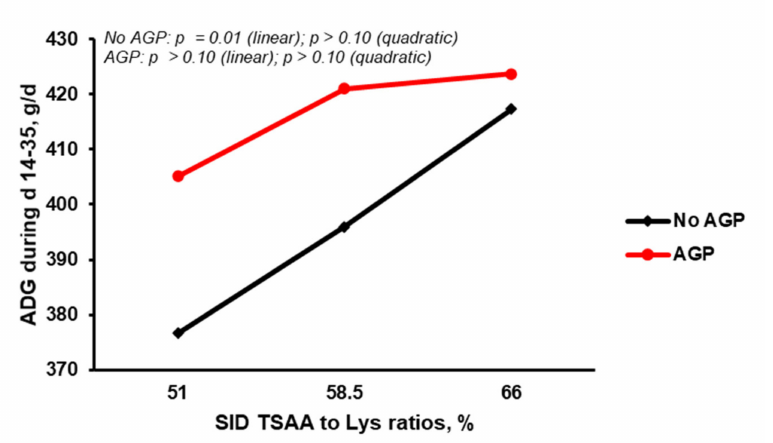
Figure 1. Effect of antibiotic growth promoter (AGP) and standardized ileal digestible (SID) total sulfur amino acids to lysine ratio (TSAA:Lys) on average daily gain of nursery pigs from d 14 to 35 (orthogonal contrast analysis).